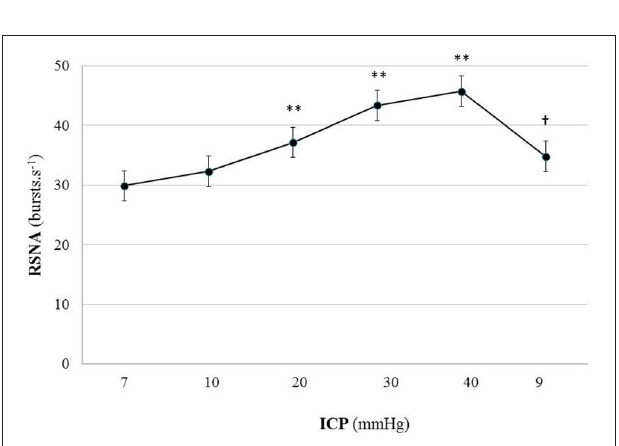
FIGURE 4 | Graph of RSNA changes during modest ICP increase and decrease in animal ( n = 15). Mean ± sem values of RSNA values at various ICP levels. Statistical analysis was performed using ANOVA for repeated measures with Tukey’s post-test. ** p < 0.01 vs. baseline and † p < 0.05 vs. plateau.